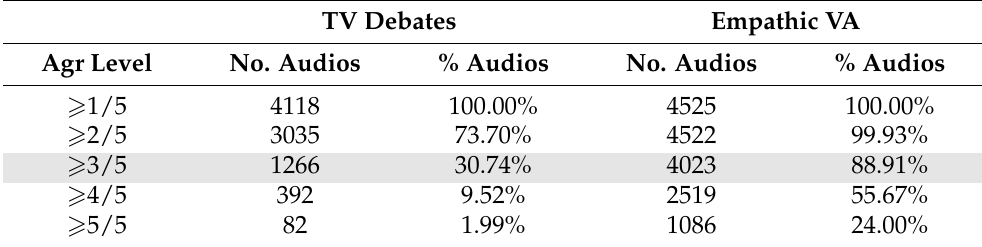
Table 3. Statistics of the agreement per audio chunk for each corpus. Column Agr. Level indicates the condition, i.e., the minimum inter-annotator agreement, and the next two columns (No. Audios and % audios), indicate how many samples and what percentage of them fulfilled the agreement